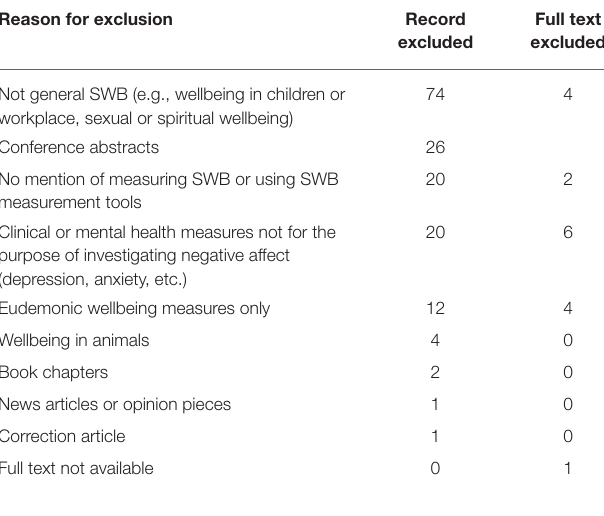
TABLE 2 | Summary of excluded studies.